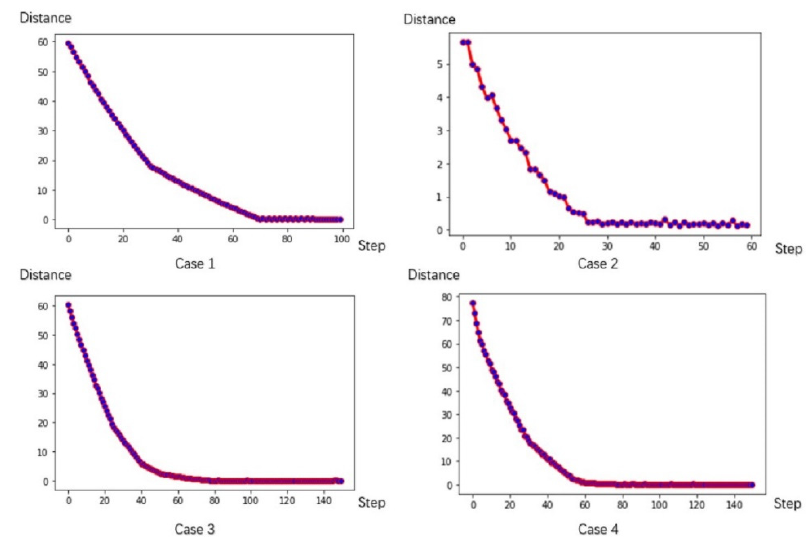
Figure 4. Distance with steps.